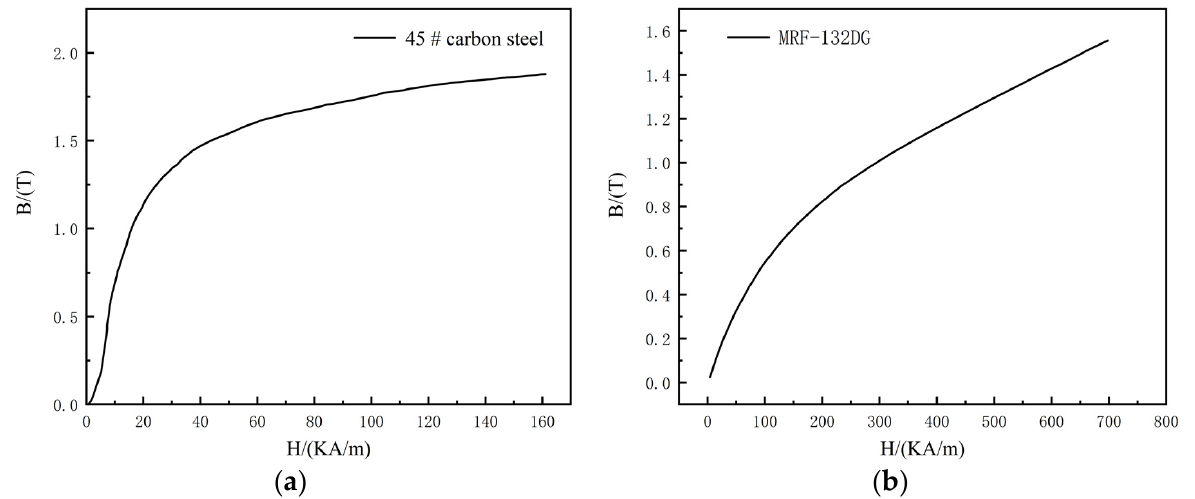
Figure 3. B-H curve of 45# carbon steel and magnetorheological fluid. ( a ) 45#carbon steel; ( b ) MRF-132DG. Table 2. Properties of Magnetorheological Fluid and 1045 Structural